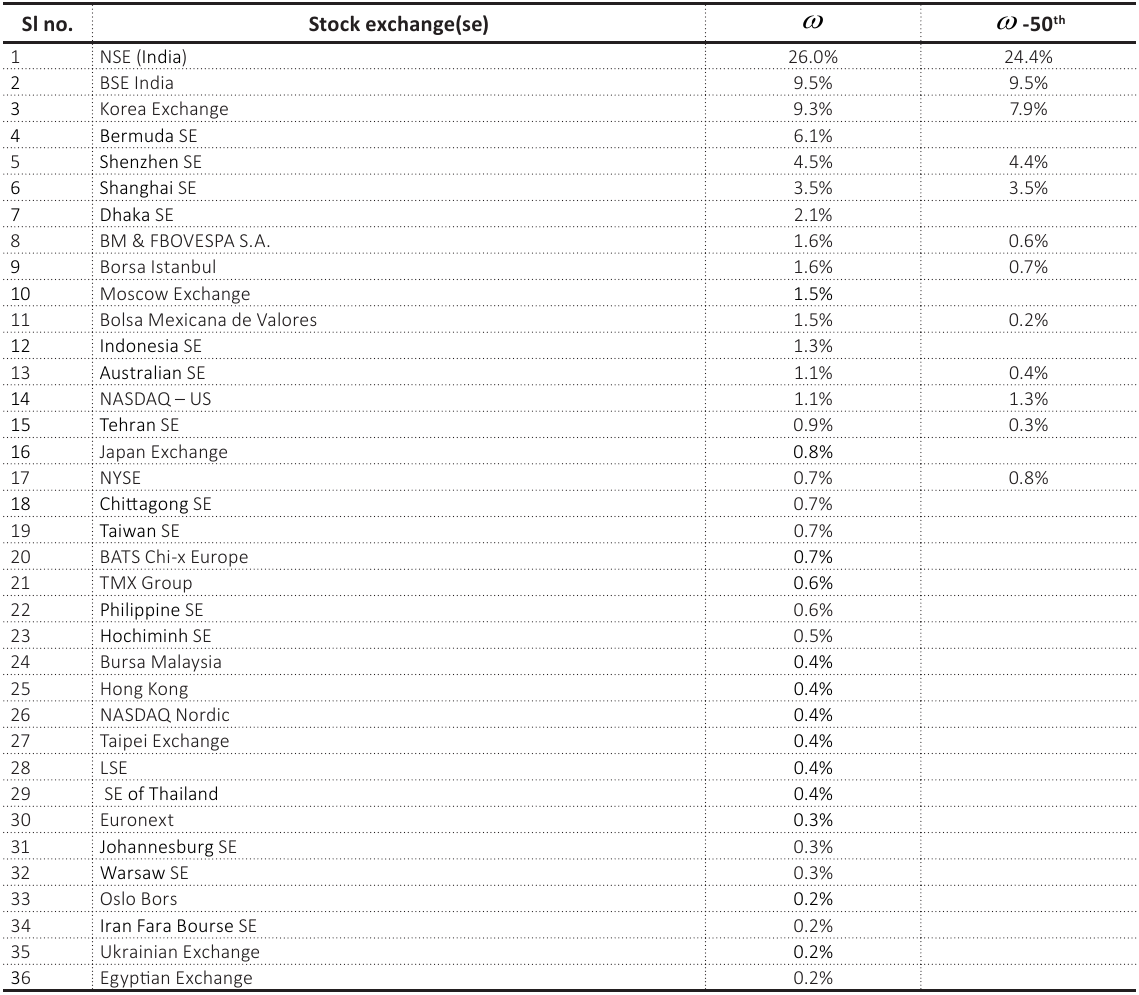
Table 2. 2018 values for ;